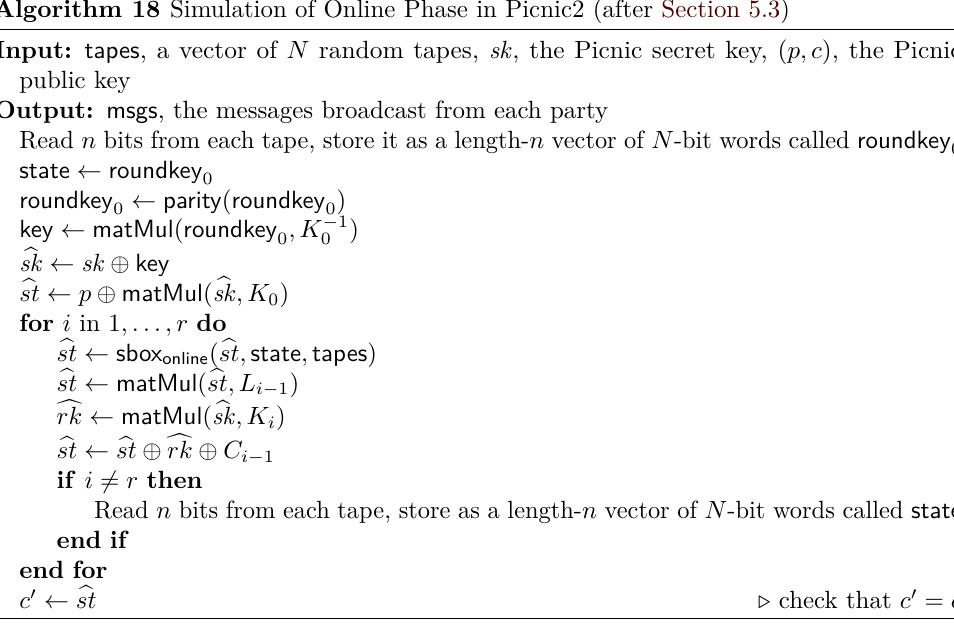
Algorithm 18 Simulation of Online Phase in Picnic2 (after Section 5.3)